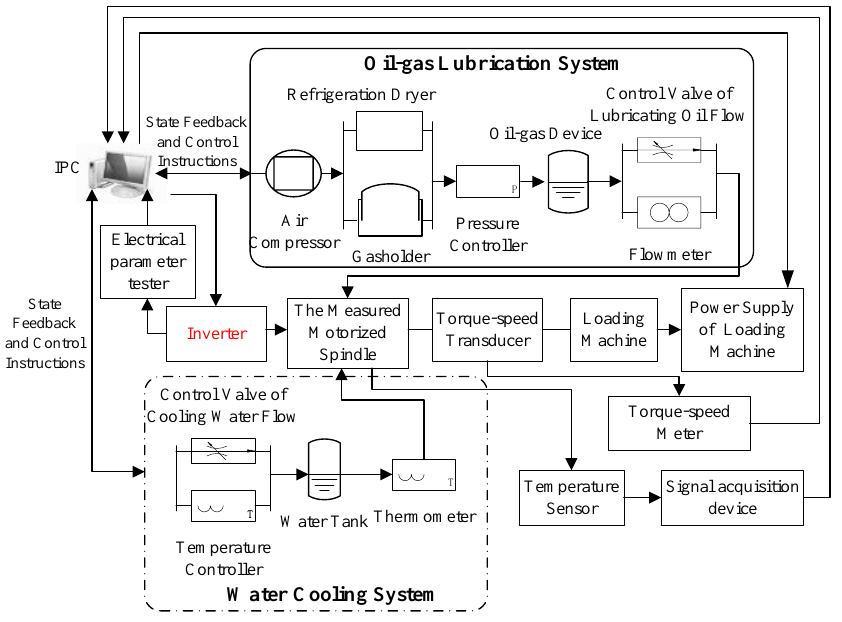
Figure 5. Temperature testing system of the motorized spindle.